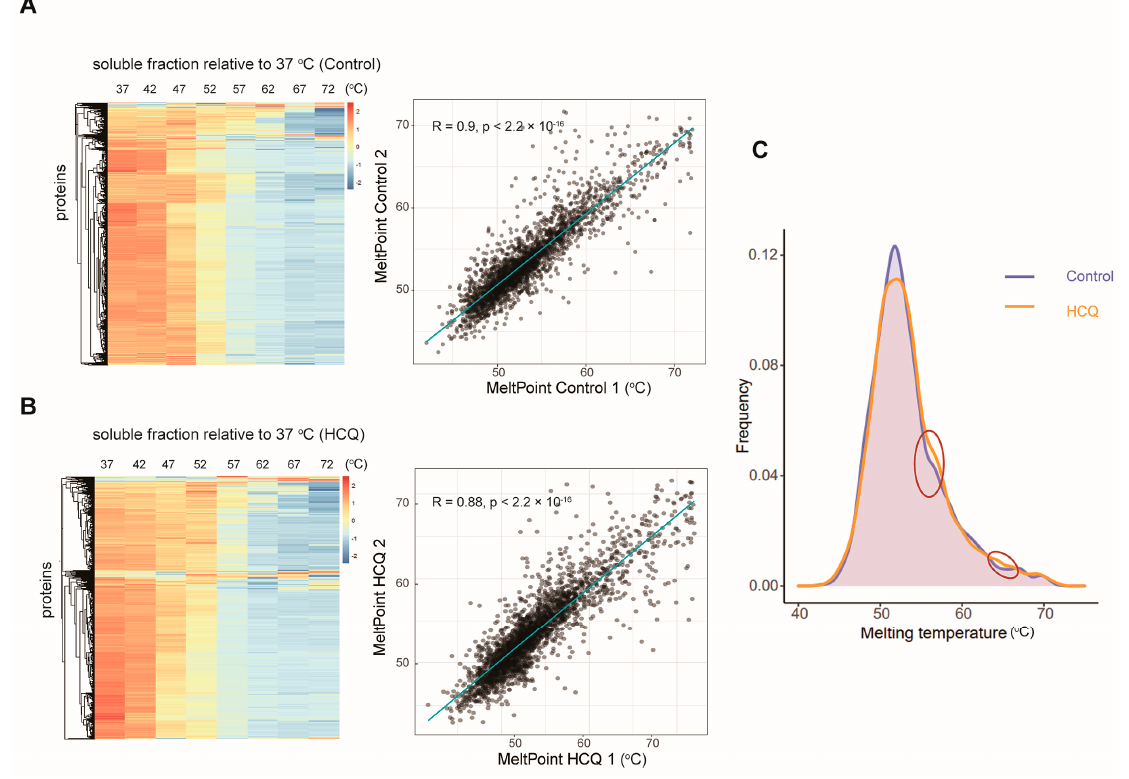
Figure 6. Thermal proteome analysis of the soluble proteins. ( A ) Heat map of the soluble proteins in the control group. Relative abundances of the 4144 soluble proteins at the corresponding temperature compared with the lowest temperature (37 ◦ C) are clustered and shown. The correlation between the two replicates is 0.9. ( B ) Heat map of the soluble proteins treated with HCQ. Relative abundance of the 4327 soluble proteins at the corresponding temperature compared with the lowest temperature (37 ◦ C) are clustered and shown. The correlation between the two replicates is 0.88. ( C ) Melting points of the total proteins in the control (purple) or HCQ-treated group (orange) are shown. The circle represents the proteins whose melting points increased after HCQ treatment.